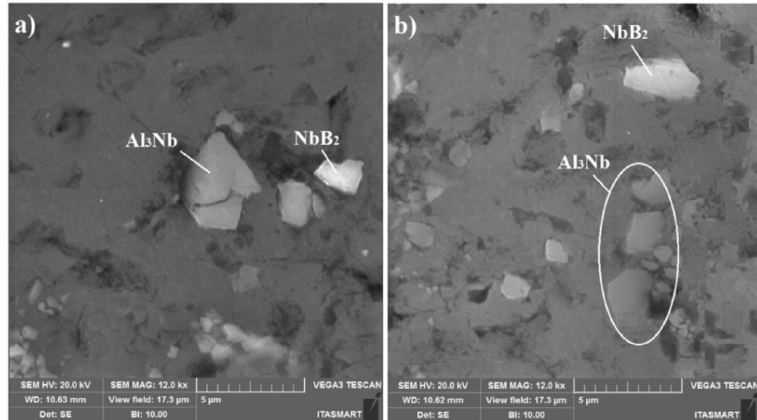
Nb and NbB substrates identified in the scanning electron microscope (SEM), with a detector analyzer (SEM-EDS), Figure 3. (a and b) Al 3 2 present in the core of the primary α-Al grain, found in the Al7Si1Fe alloy, with the addition of 0.5% Nb.